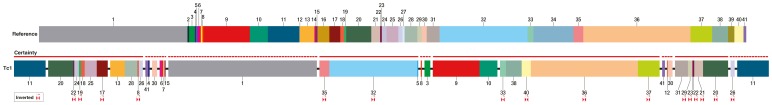
Schematic of the proposed structure of Tc1-Hsa21.Reference: Ideogram of human chromosome 21, numbers 1–41 indicate regions of Tc1 Hsa21 delineated according to Table S5. Tc1: rearranged structure of the Hsa21 in Tc1 mice. The order of regions 11, 20, 22, 24, 19, 18, 25, 17, 13, 28, 26, 6, 15, 35, 32, 5, 9, 10, 33, 38, 40, 36, 37, 31, 29, 23, 22, 21, 20, and 11 in this schematic are based on FISH mapping data (Fig. S2). The certainty of the rearrangement is indicated by a red line, solid line more certain, dotted line suggested. Inverted chromosome regions are indicated by the red arrow symbol. Region 12 is triplicated but the position of the other two copies is unknown. Position of region 27 is unknown. The positions of acrocentric regions 1, 2, 3, 7 and 8 are unknown and are placed arbitrarily. Regions 26, 30 and 41 are duplications and their positions are suggested by FISH within the resolution of the technique. Regions 14, 16, 34 and 39 are deleted.